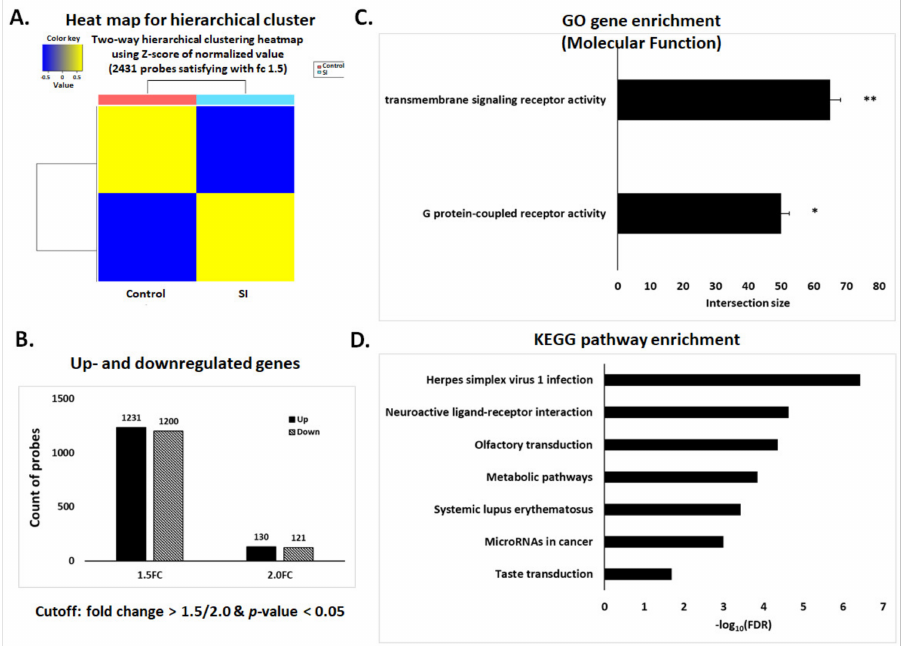
Figure 3. Transcriptomic analysis: ( A ) heat maps of differentially expressed genes in cells subjected to sham and FIR; ( B ) a graph of the number of significantly upregulated and downregulated genes in cells; ( C , D ) bar graphs displaying GO enrichment and KEGG pathway enrichment, respectively, show that there are differentially expressed genes between sham and FIR-exposed cells. Data are shown as the mean ± standard deviation ( n = 3) after a two-tailed paired Student’s t -test (* p < 0.05 and ** p <